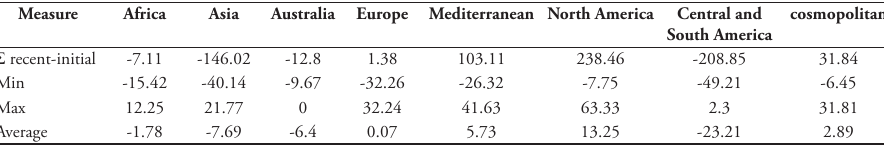
table 1. Statistics showing the difference in abundance (i.e. recent vs initial state). Positive values indicate increase in abundance over time for the given group, negative values reflect decrease.